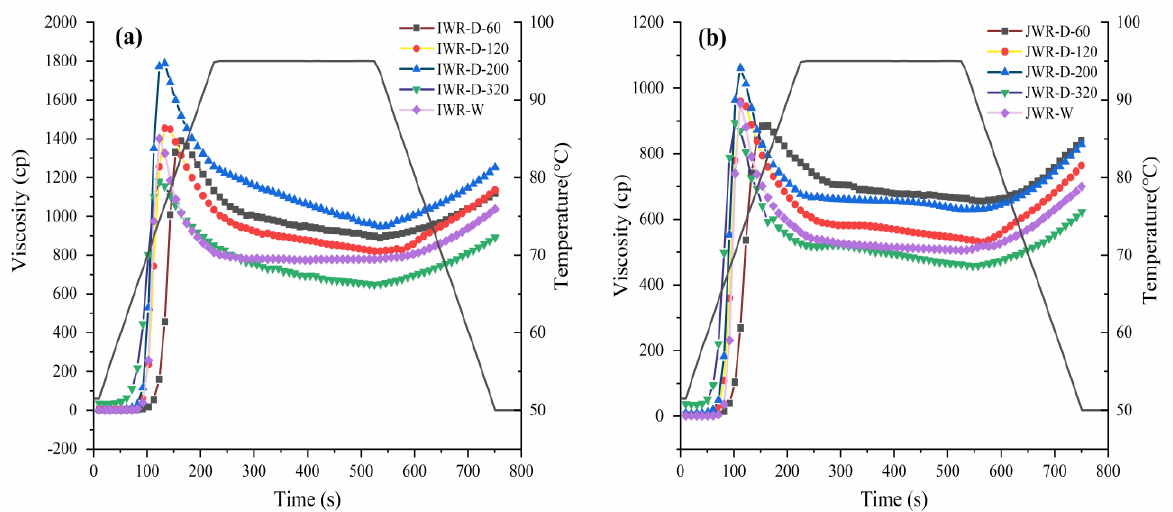
Figure 1. The pasting viscosity of waxy rice flour. ( a ) stands for the pasting viscosity of different particle size of IWR − D and IWR − W; ( b ) stands for the pasting viscosity of different particle size of JWR − D and JWR −